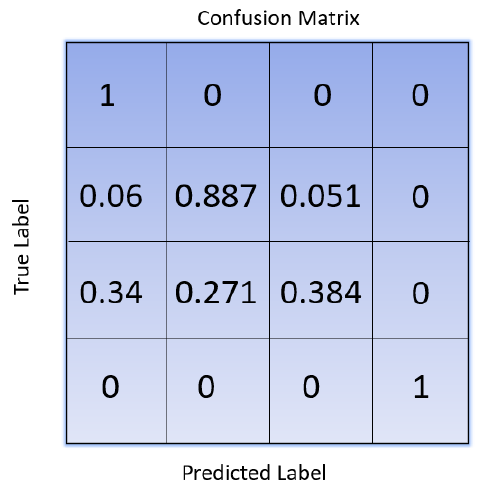
Figure 7. Selection of optimal time horizon for Hierarchical LSTM-SAE Level 1 model.